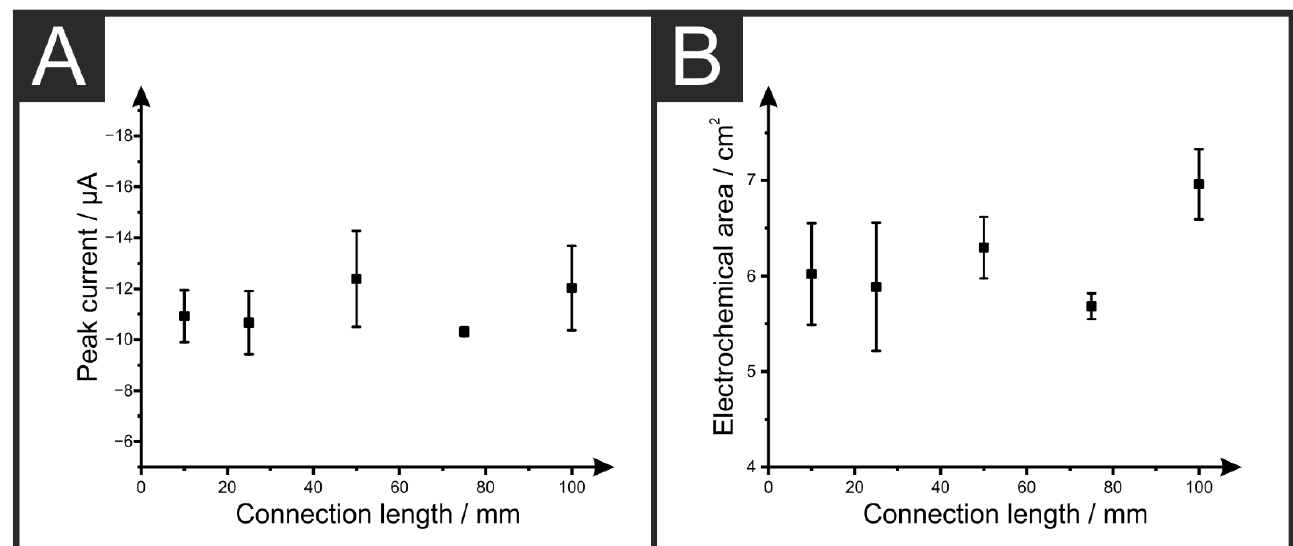
Figure 3. ( A ) Plot of the average peak current ( n = 5) obtained for the reduction of RuHex (1 mM in 0.1 M KCl) at 50 mV s − 1 for AMEs of different connection lengths. ( B ) Plot of the average calculated electrochemical area of the different connection length AMEs.